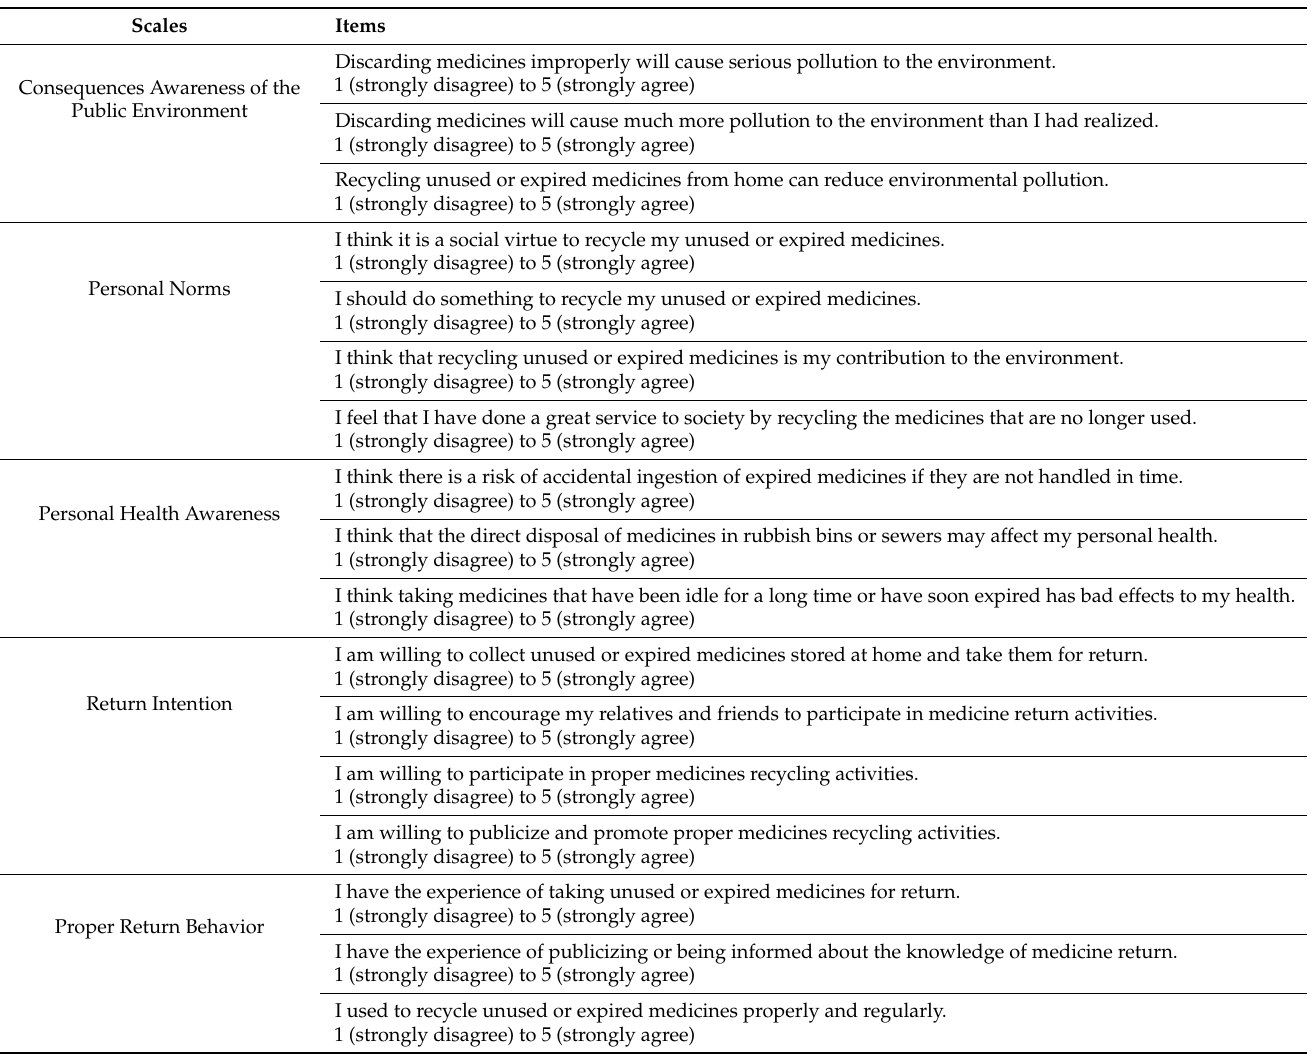
Table A1. Survey on Medicines Recycling